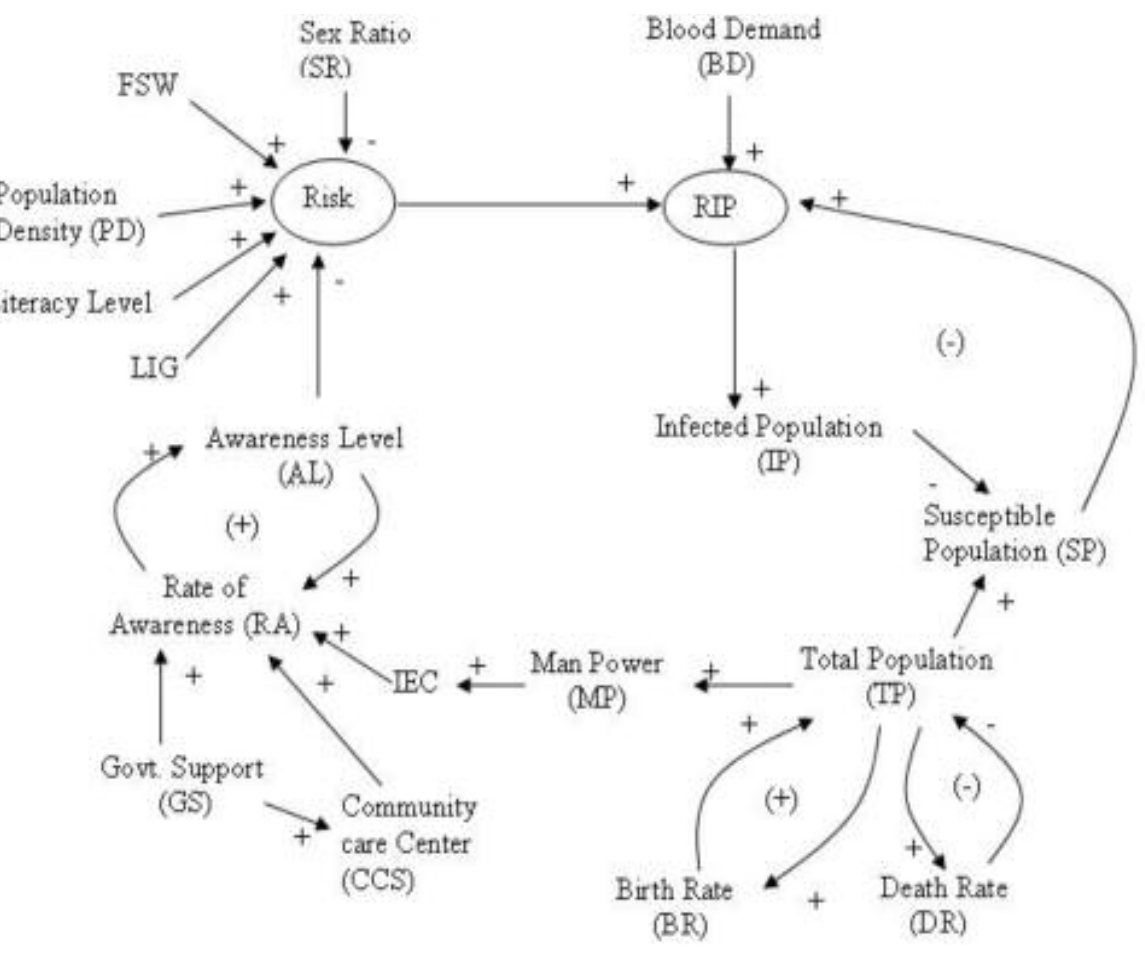
Figure 6: Causal Loop Diagram for HIV/AIDS